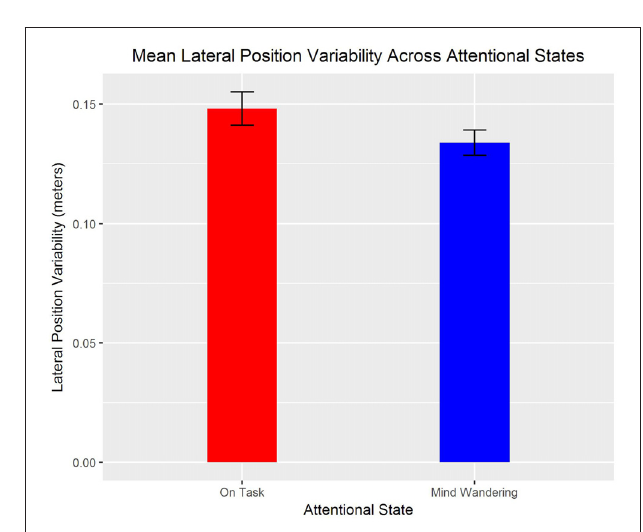
FIGURE 6 | Means and standard errors of the standard deviation of lateral position (SDLP) for “mind wandering” and “on task” attentional